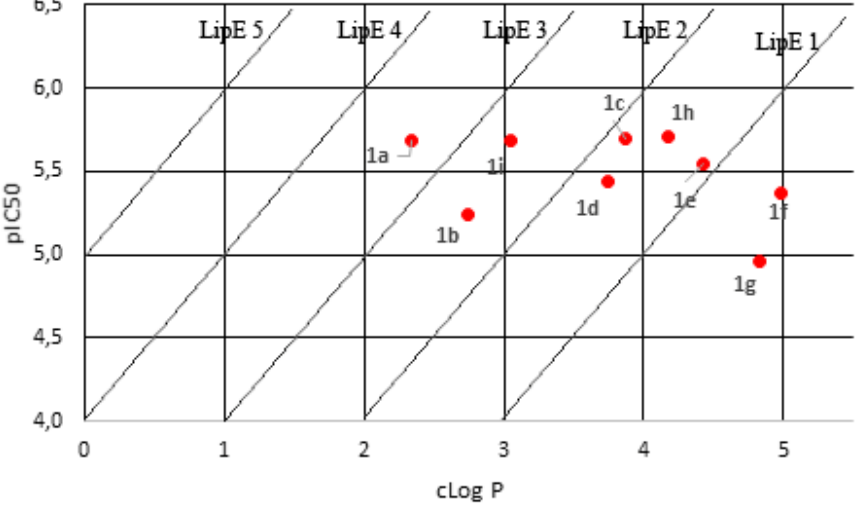
plot and LipE 50